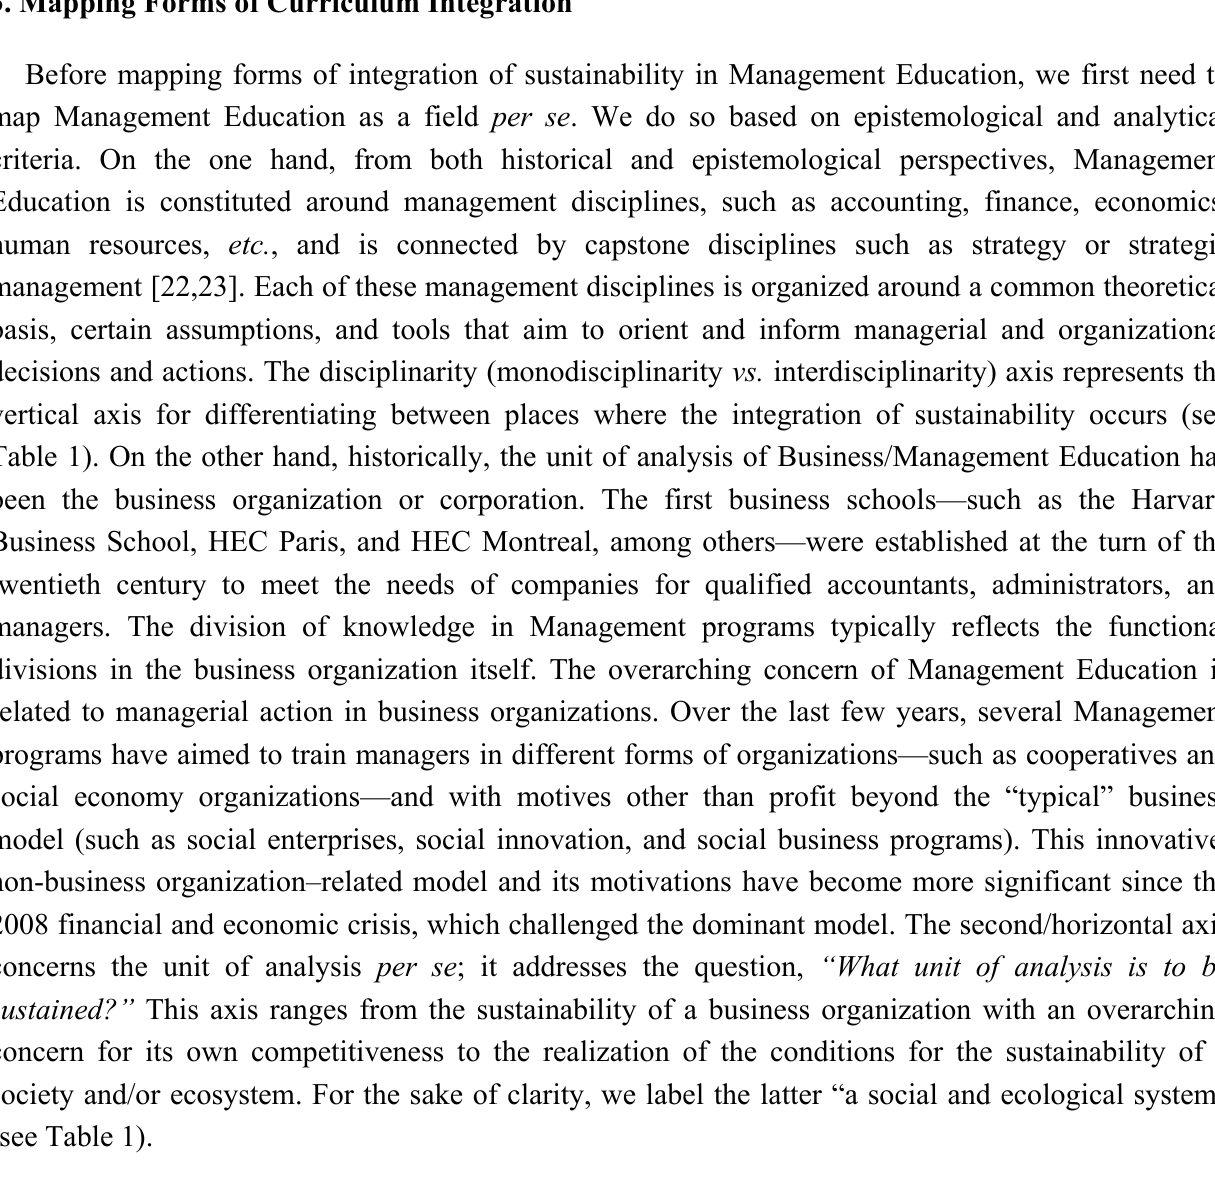
Table 1. Four forms of